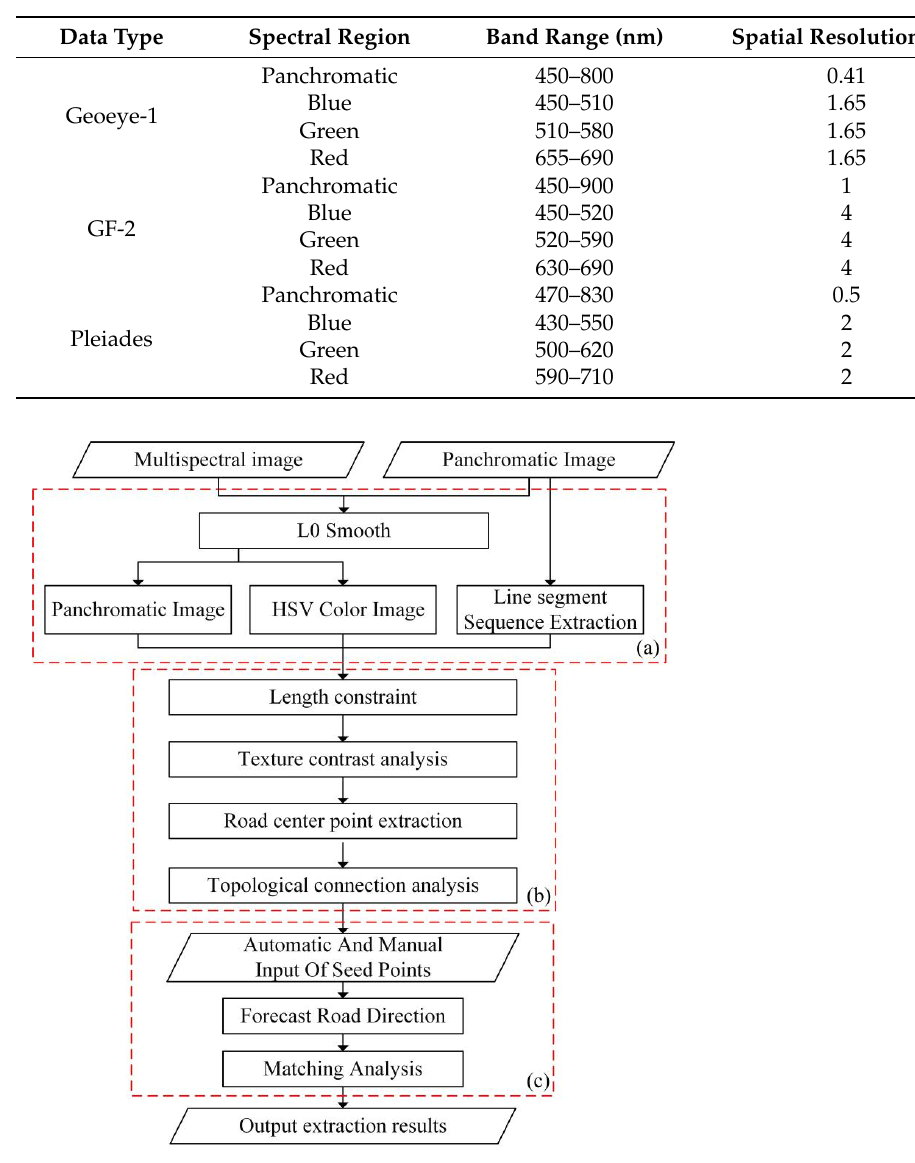
Table 1. Technical specification of different remote sensing image used in this study.